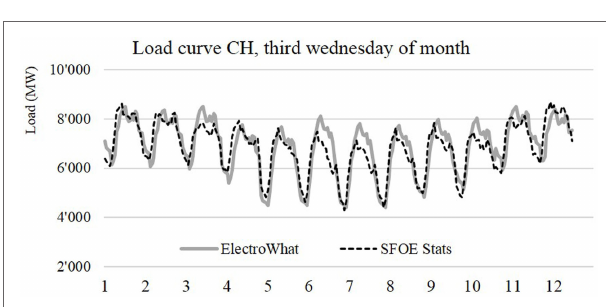
FIGURE 11 | Actual and simulated average hourly load curve from January (1) to December (12) 2008 for